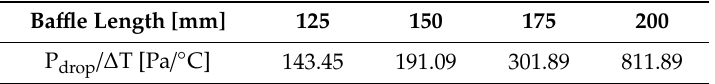
Table 7. Pressure drop and temperature di ff erence ratio depending on length.